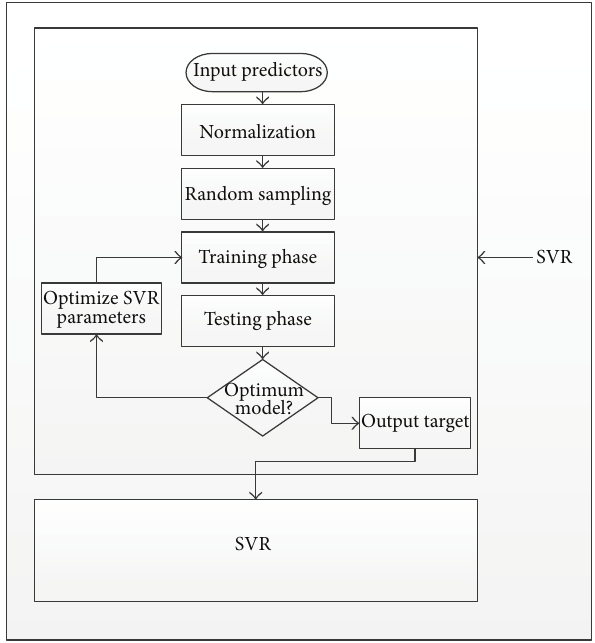
Figure 1: Flow chart for homogenous hybridization of